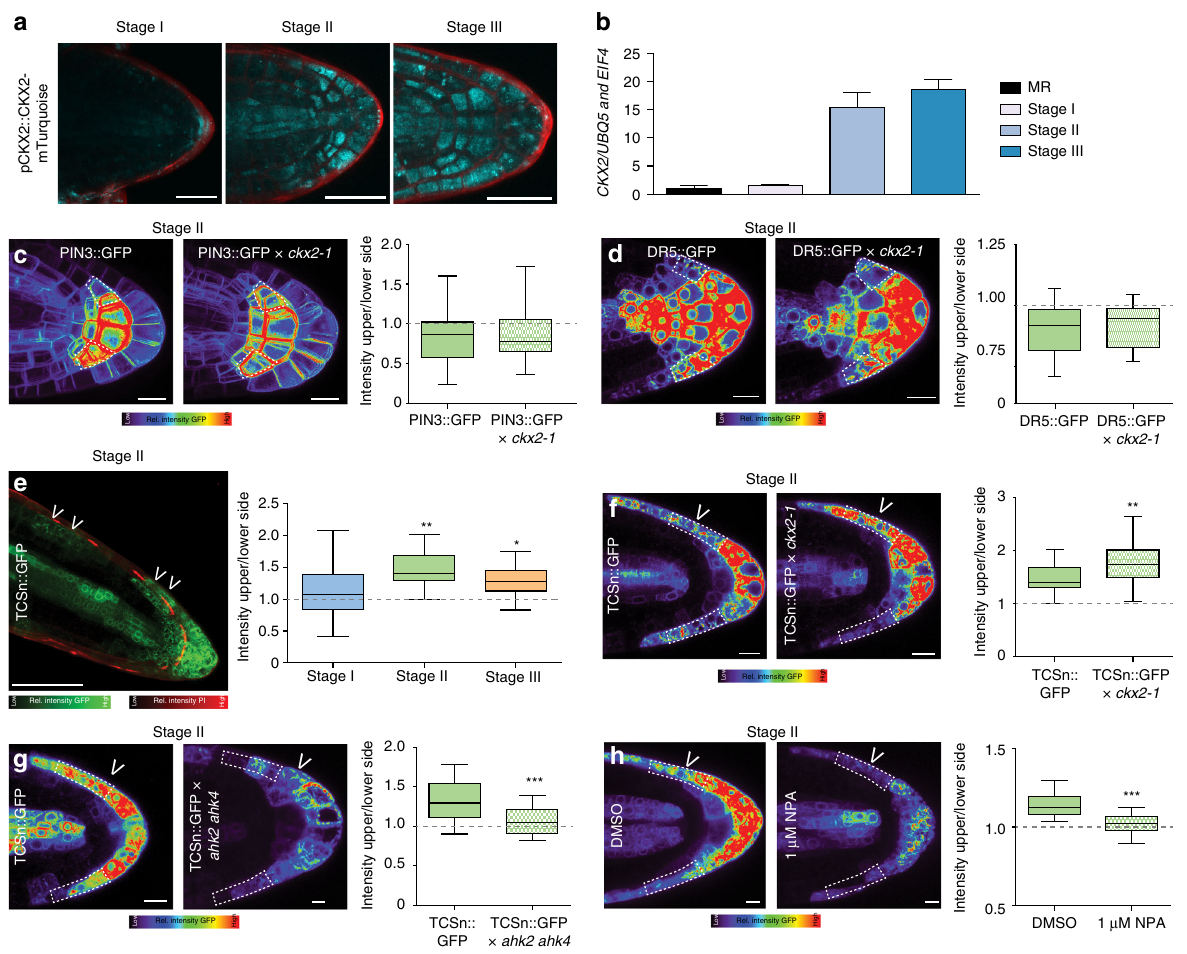
Fig. 6 CKX2 modulates asymmetric cytokinin signaling in emerged lateral roots. a Representative images of pCKX2::CKX2-mTurquoise in stages I – III LRs. Propidium Iodide (PI) was used for counterstaining. Scale bar, 25 µ m. b qPCR analysis detecting the levels of CKX2 transcript in the root tip and LRs stages I – III normalized against UBQ5 and EIF4 . Bars represent means ± SD, n = 3. c , d Representative images and signal quanti fi cation of stage II LRs of c pPIN3:: PIN3-GFP, and d DR5::GFP in Col-0 wild type and ckx2-1 mutant background. Horizontal lines show the medians; box limits indicate the 25th and 75th percentiles; whiskers extend to the min and max values, n = 10 – 15 individual LRs. Scale bars, 10 µ m. e Representative image (stage II) and quanti fi cation of TCSn::GFP in stages I – III LRs. PI was used for counterstaining. Scale bar, 50 µ m. f – h Representative images and quanti fi cation of stage II LRs of f TCSn::GFP in wild type and ckx2-1 , g TCSn::GFP in wild type and ahk2 ahk4 or h after treatment with DMSO or 1 µ M NPA for 24 h. Scale bars, 10 µ m. e – h One-way ANOVA P -values: * P < 0.05, ** P < 0.01, *** P < 0.001. Horizontal lines show the medians; box limits indicate the 25th and 75th percentiles; whiskers extend (facing the columella cells) for quanti fi